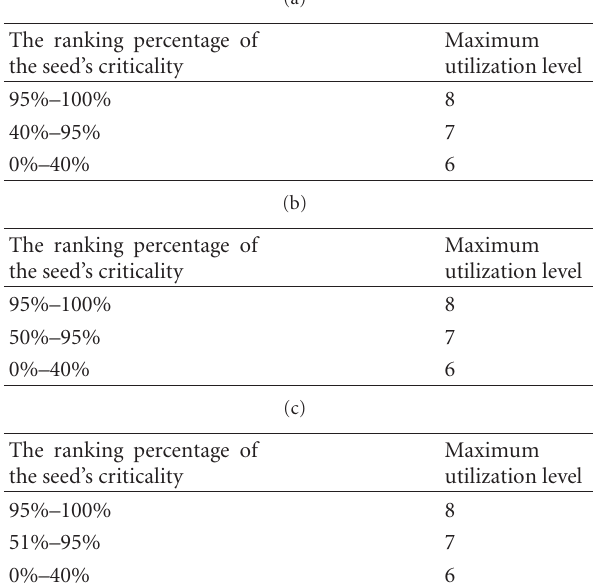
Figure 4: CAD flow. Figure 5: Distribution of CLBs based on criticality value: CLBs are uniformly distributed between 40% and 96% forming the range of Maximum Utilization Table (MUT). Table 3: FPGA architecture parameters. Table 4: Maximum utilization table (MUT) with four partitions shows three examples for potential range configurations. configu- ration in table (b) results with good quality measurements; then we fine tune the range and form table in